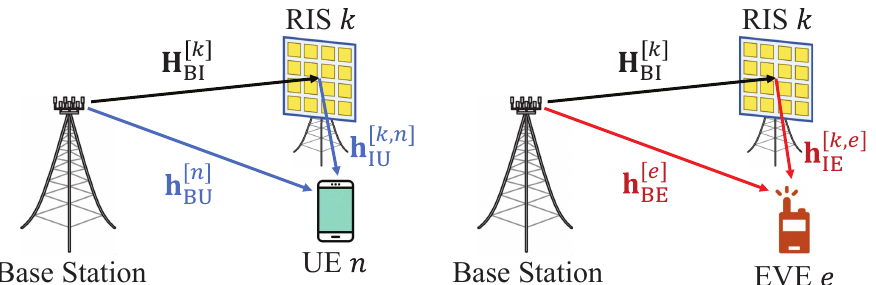
Figure 1. RIS-based communication model and channel